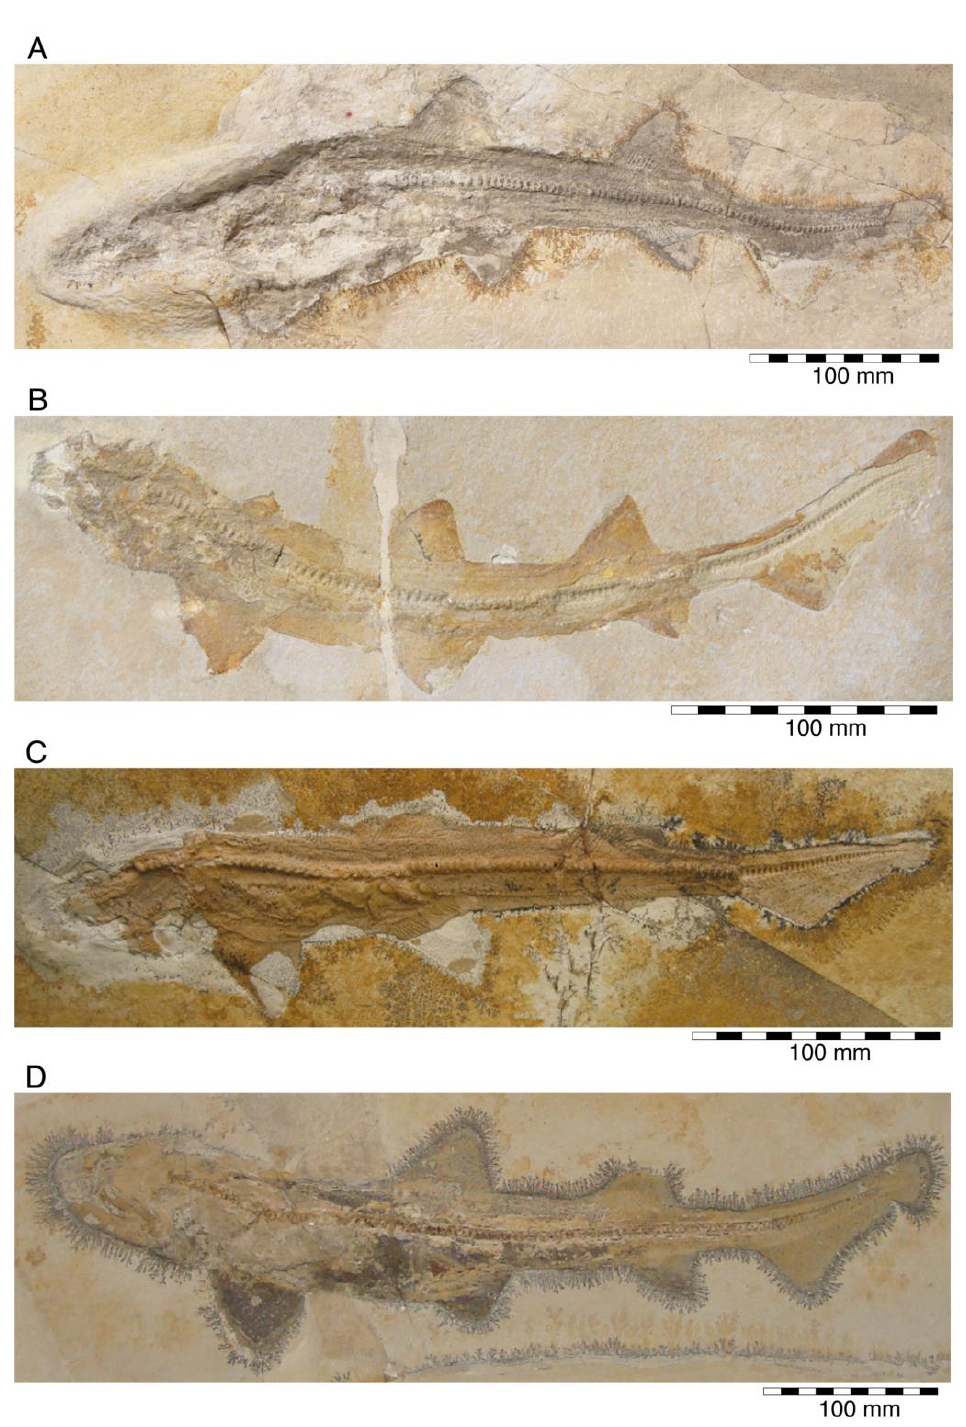
Figure 24. Specimens of † Palaeoscyllium formosum Wagner, 1857 [102]. ( A ) Holotype specimen (SNSB-BSPG AS I 1365) from the lower Tithonian of Solnhofen. ( B ) Holomorphic specimen (SNSB-BSPG AS I 589 A) from the lower Tithonian of Solnhofen. ( C ) Holomorphic specimen (JME SOS 3151) from the lower Tithonian of Solnhofen. ( D ) Holomorphic specimen (SMNK, without number). The fossil record of † Palaeoscyllium also extends into the Cretaceous based exclusively on teeth from the Valanginian of Poland († Palaeoscyllium sp. [249]), the Barremian of Eng- land († Palaeoscyllium aff. formosum [250] , † Palaeoscyllium sp. [234]), and from the Albian of England († Palaeoscyllium reticularis as † Parasymbolus reticularis Underwood and Mitchell, 1999 [241]).